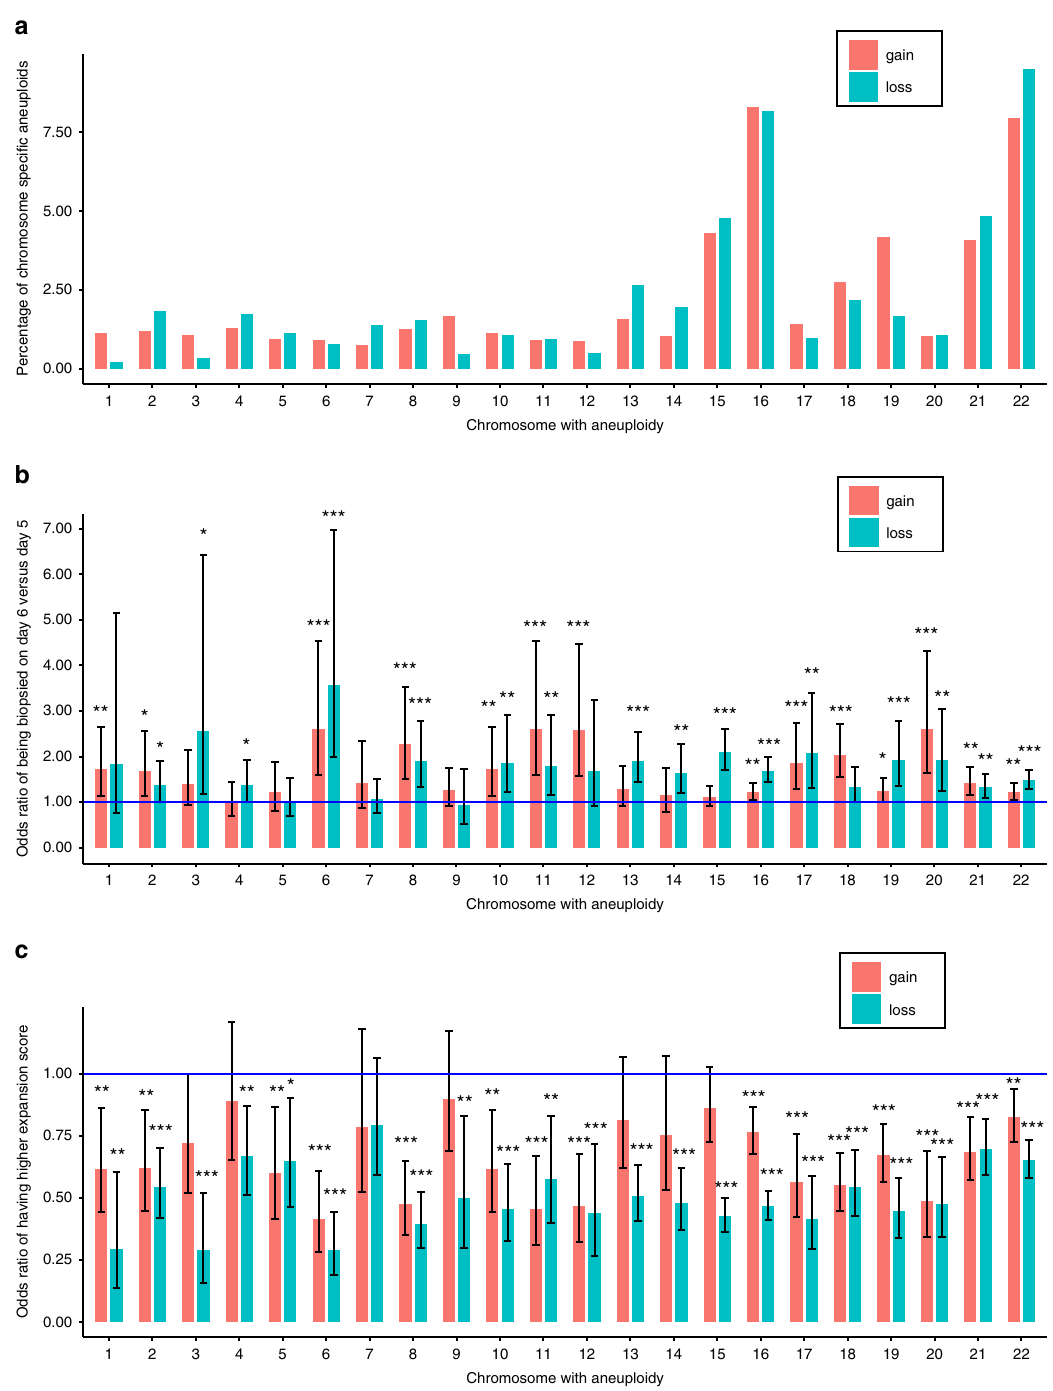
Fig. 1 Preimplantation development of aneuploid human embryos. a Prevalence of individual single chromosome aneuploidies among all embryos with single chromosome aneuploidy ( n = 9,429 embryos). b Odds ratios of embryos developing to the blastocyst stage by day 6 rather than day 5 for single chromosome gain or loss ( n = 9,429 embryos) as compared to euploid embryos ( n = 25,368). Error bars represent 95% pro fi le likelihood con fi dence intervals. Blue line represents odds for euploid embryos. Con fi dence intervals, p values and the speci fi c number of embryos analyzed per genotype is shown in the Source Data fi le. c Odds ratios of embryos having a higher day 5 expansion score for single chromosome gain or loss ( n = 9,429 embryos) as compared to euploid embryos ( n = 25,368). Error bars are 95% pro fi le likelihood con fi dence intervals. Blue line represents odds for euploid embryos. Orange bar represents gain of chromosome (trisomy) while cyan bar represents loss of chromosome (monosomy). Con fi dence intervals, p values and the speci fi c number of embryos analyzed per genotype is shown in the Source Data fi le. * p < 0.05, ** p < 0.01, *** p < 0.001. Source data are provided as a Source Data fi